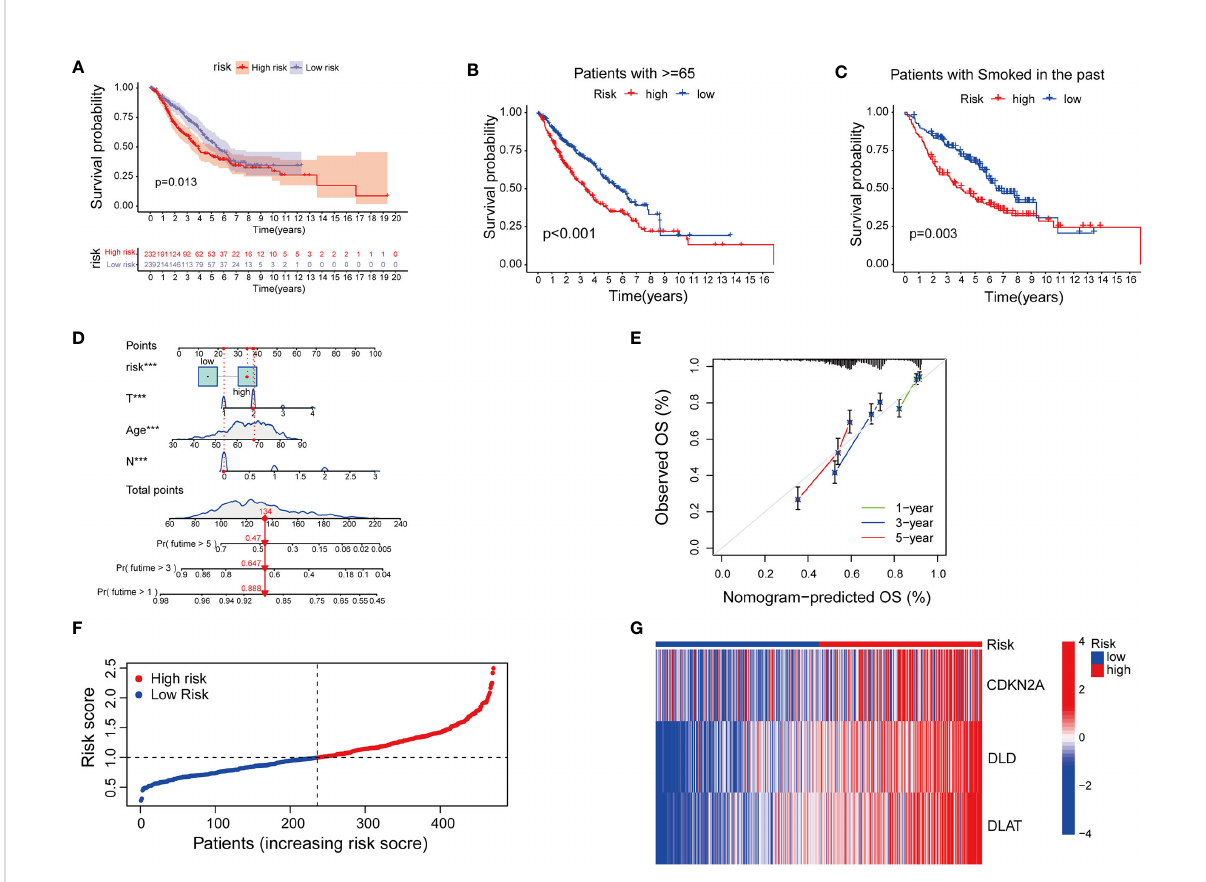
FIGURE 4 Cuproptosis-related gene model predicts the clinical outcomes of LUAD patients. (A) Kaplan-Meier curves of LUAD subgroups divided by cuproptosis-related gene model. (B, C) Cuproptosis-related gene model predictive of poor overall survival among patients older than 65 years and smoking history. (D) Nomogram showing the ef fi cacies of cuproptosis-related gene model for predicting the RFS of 1, 3, and 5 years in LUAD patients. (E) Calibration curves of the nomogram for predicting 1-, 3-, and 5-year OS in LUAD samples. (F, G) A risk prediction model based on the cuproptosis-related gene